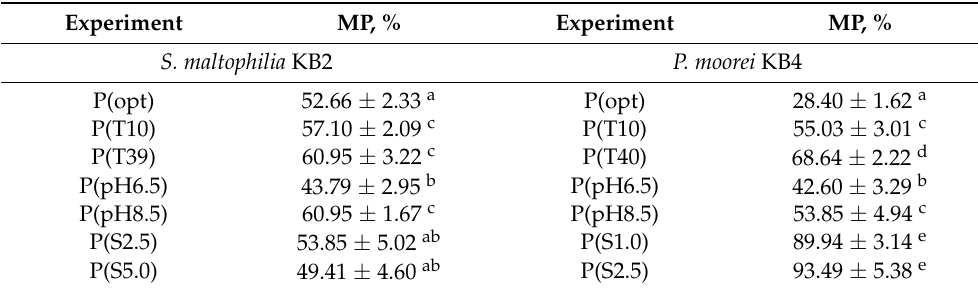
Table 4. Membrane permeability (MP) of S. maltophilia KB2 and P. moorei KB4 grown on phenol under various culture conditions.